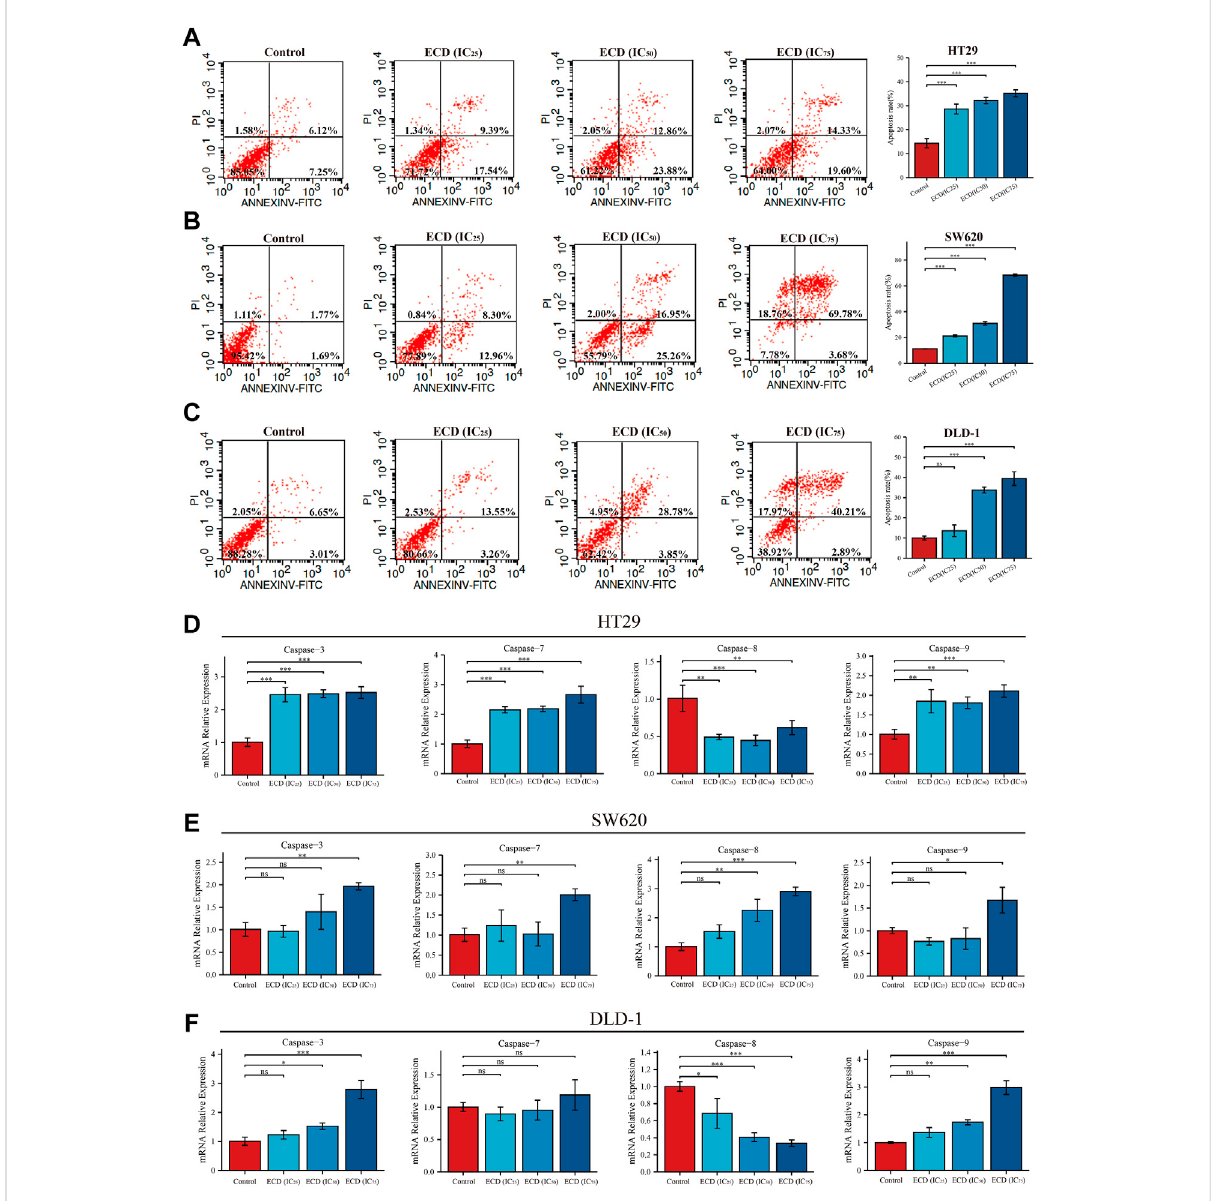
FIGURE 9 ECD induced cell apoptosis of CRC cells. (A – C) Cell apoptosis analyses of HT29 (A) , SW620 (B) , and DLD-1 (C) cell lines treated with different